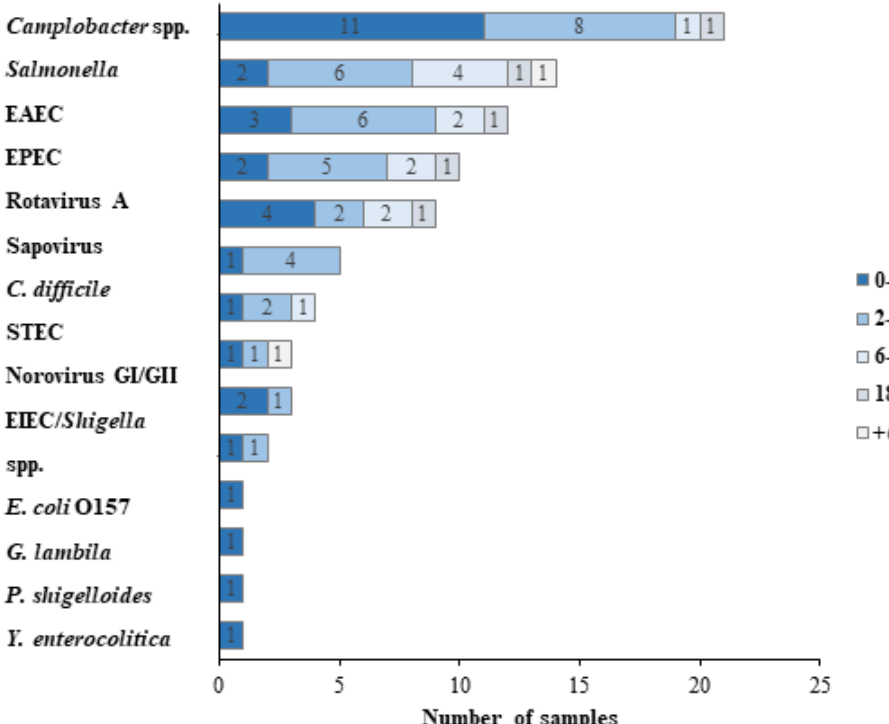
5 of 11 Figure 2. Coinfections detected in GIP-positive specimens. Among the 61 positive stool samples, 24 samples were positive for more than one pathogen (i.e., coinfection), with various combinations of pathogens, as presented in the graph.